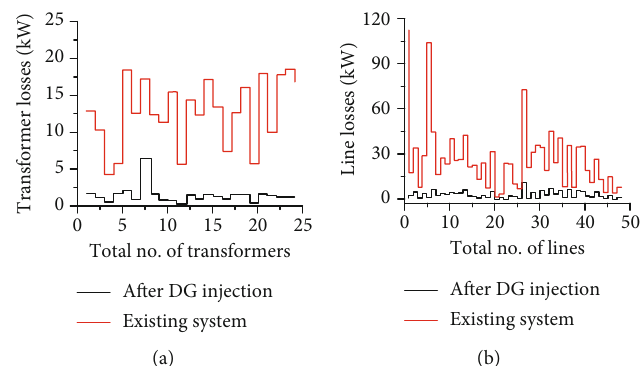
Figure 16: (a) Transformer losses and (b) line losses before and after DG in zone A.